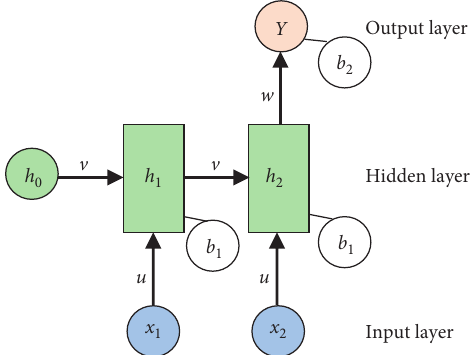
Figure 2: Structure diagram of RNN with two hidden layers.